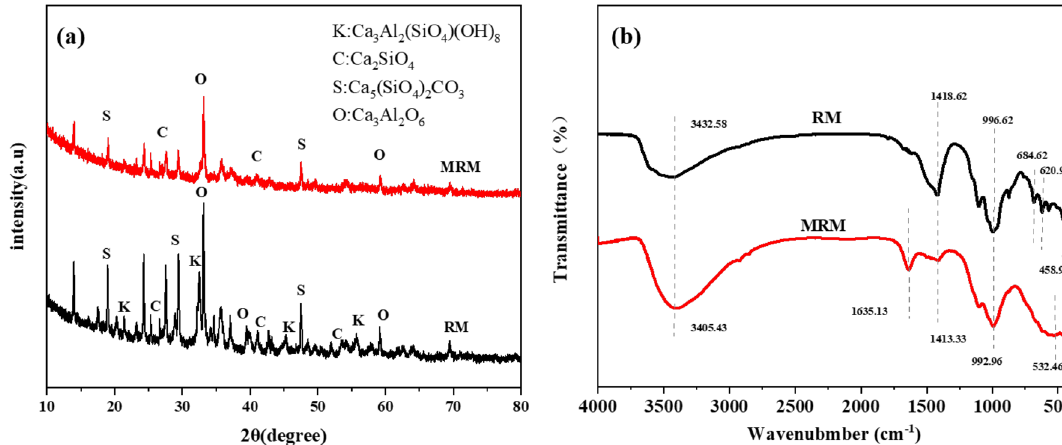
Figure 2. The XRD ( a ) and FTIR ( b ) of RM and MRM.